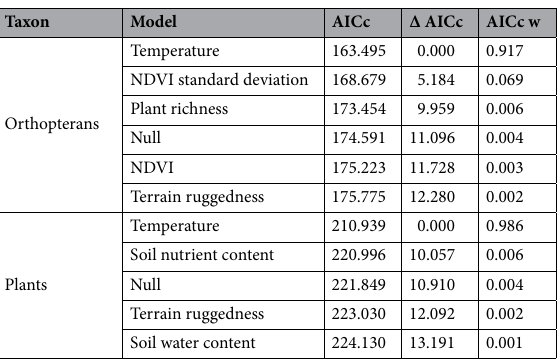
Table 1. Model selection results of orthopteran and plant species richness. Coeff. Coefficient, AICc Akaike information criterion corrected for small sample size, AICc w weights of the Akaike information criterion corrected for small sample